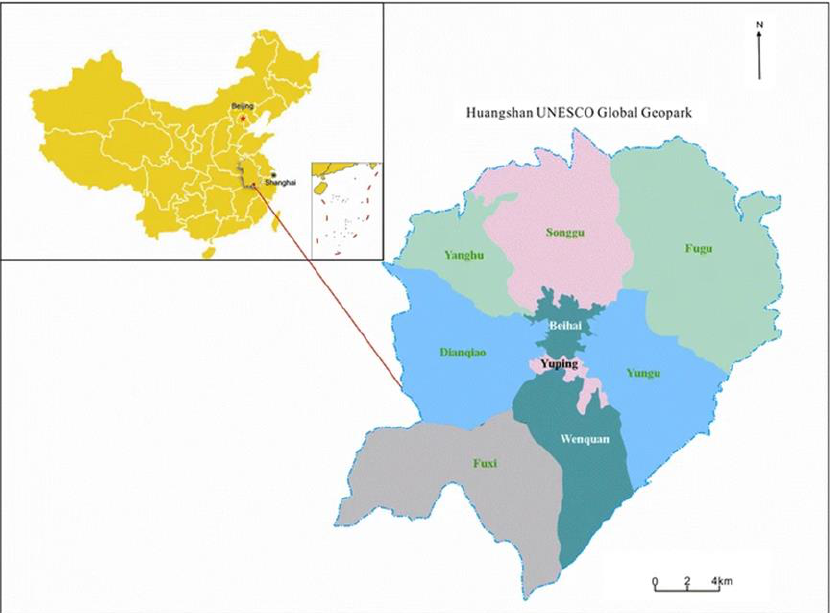
Figure 2. Location of Mt.Huangshan [36].